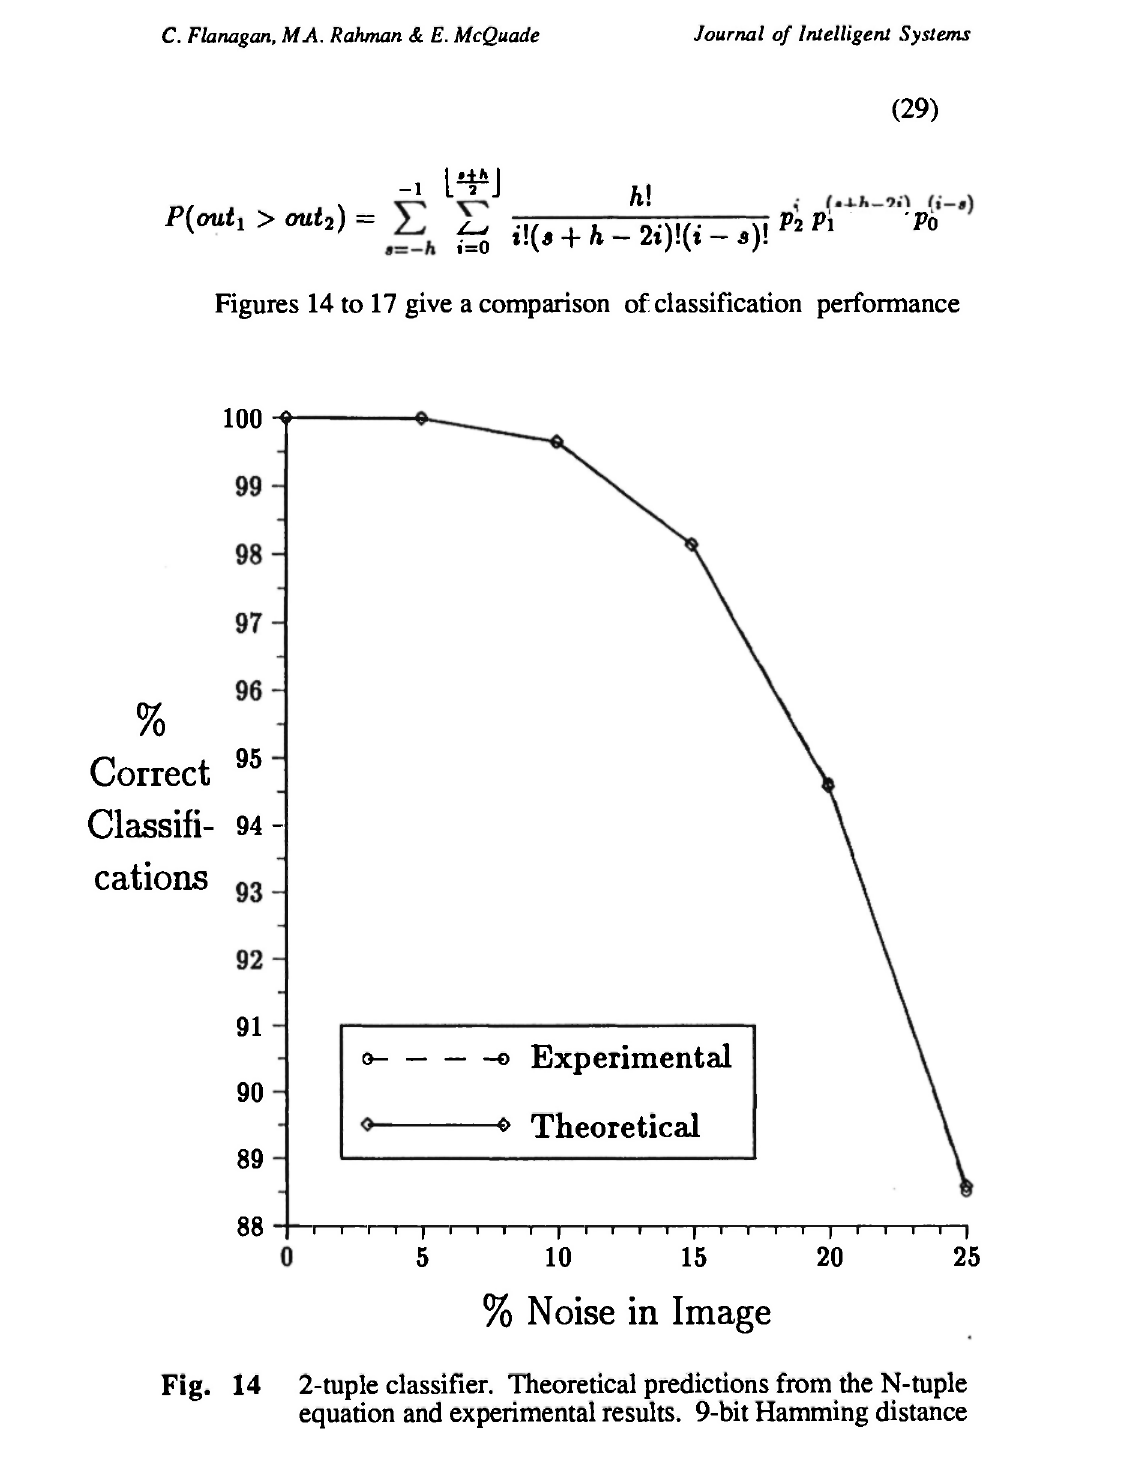
Fig. 14 2-tuple classifier. Theoretical predictions from the N-tuple equation and experimental results. 9-bit Hamming distance